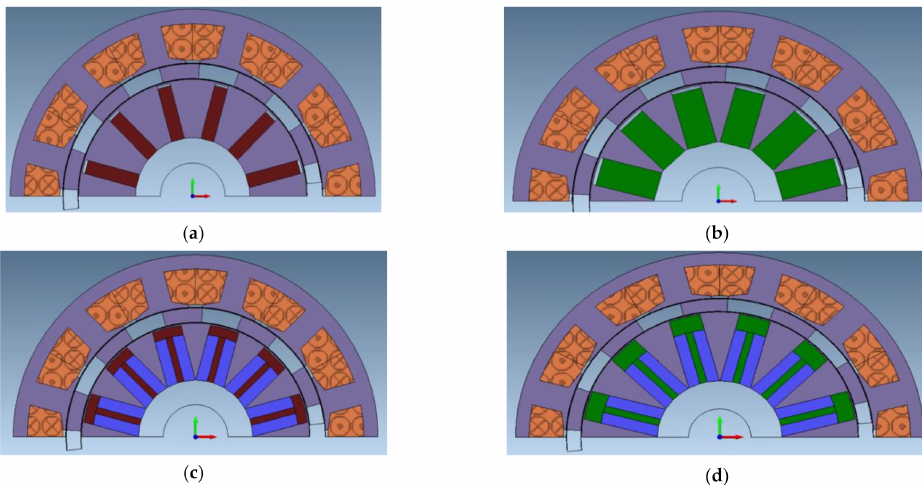
Figure 12. FE repetitive models of the considered FSM designs ( a ) Dy-NdFeB Design, ( b ) Dy-free NdFeB, ( c ) Dy-NdFeB with Ferrite Design, and ( d ) Dy-free NdFeB with Ferrite Design. Table 11. Geometrical changes in various